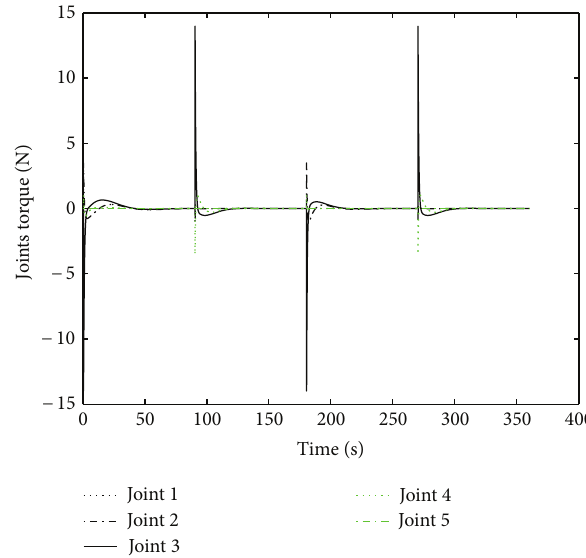
Figure 13: The space station, base frame, and robot initial and final configuration for wheels locomotion.